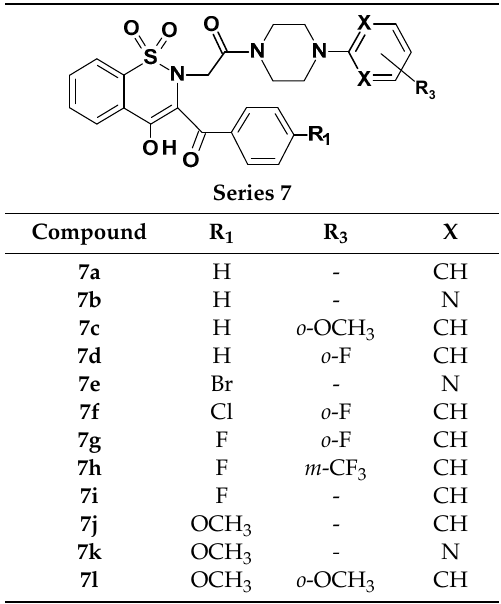
Table 8. Structures of series 7 compounds.